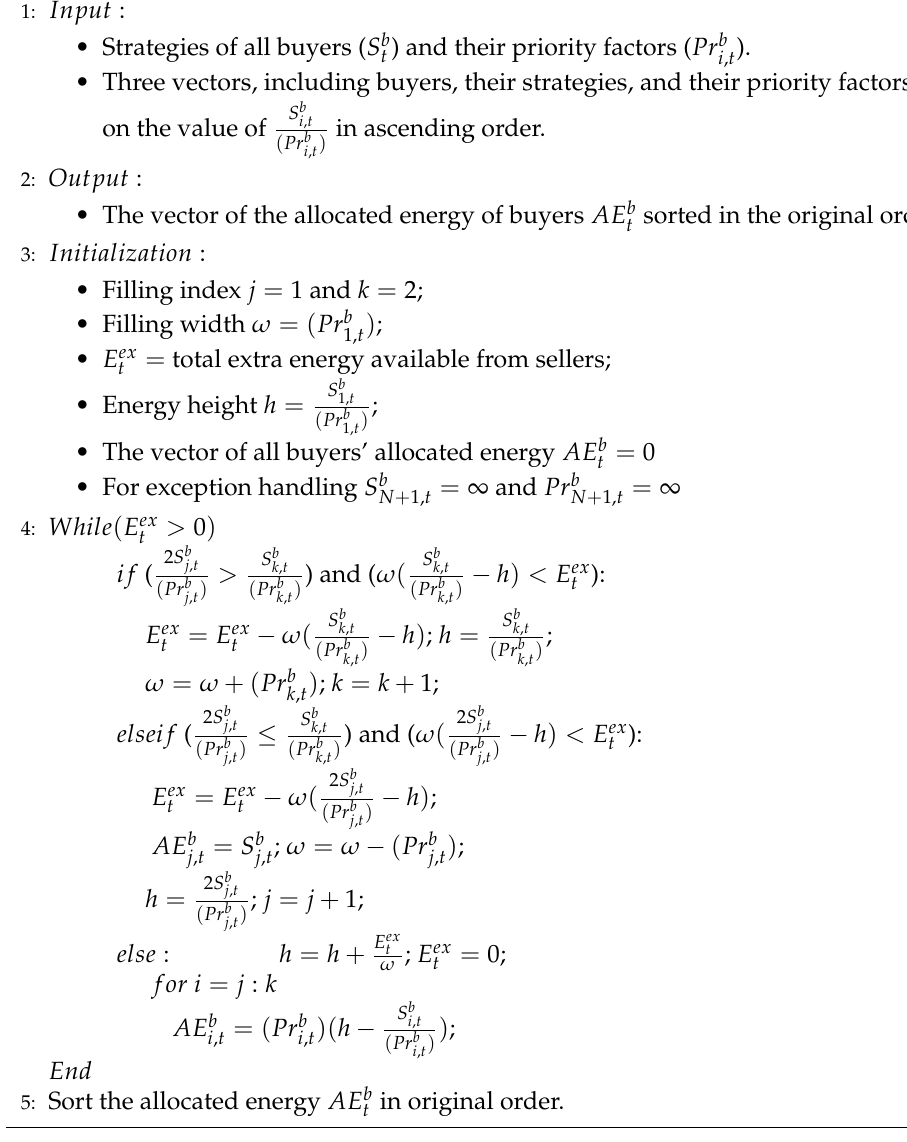
Algorithm A2 Allocating Energy to Buyers by